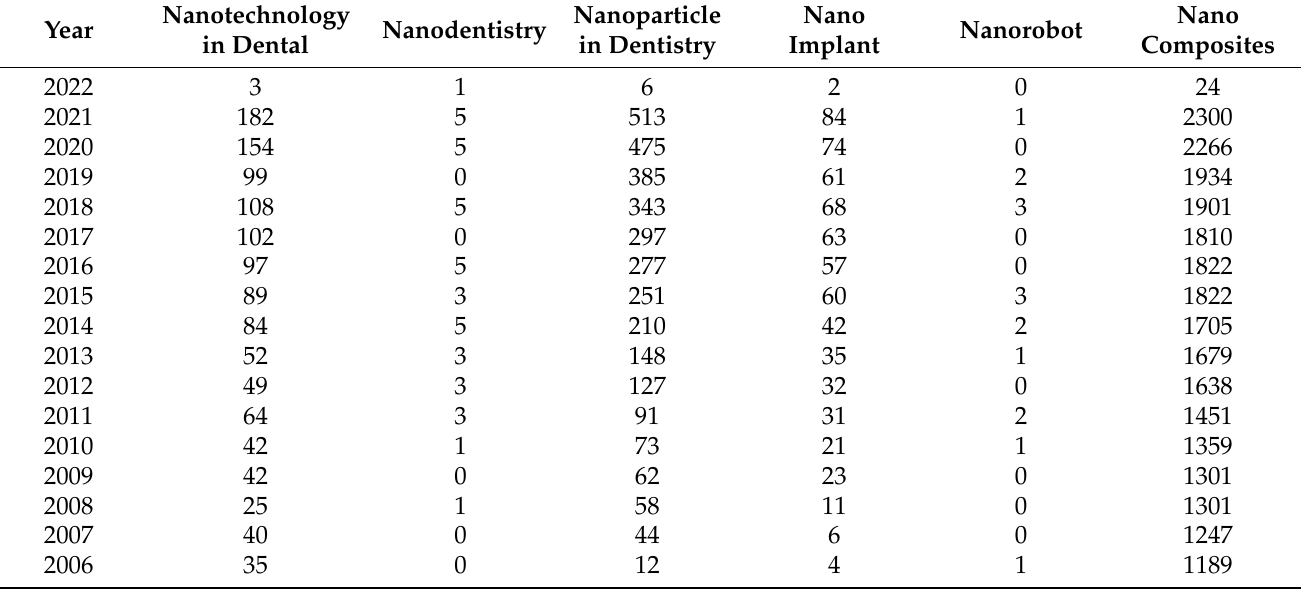
Table 1. Research topic click number in